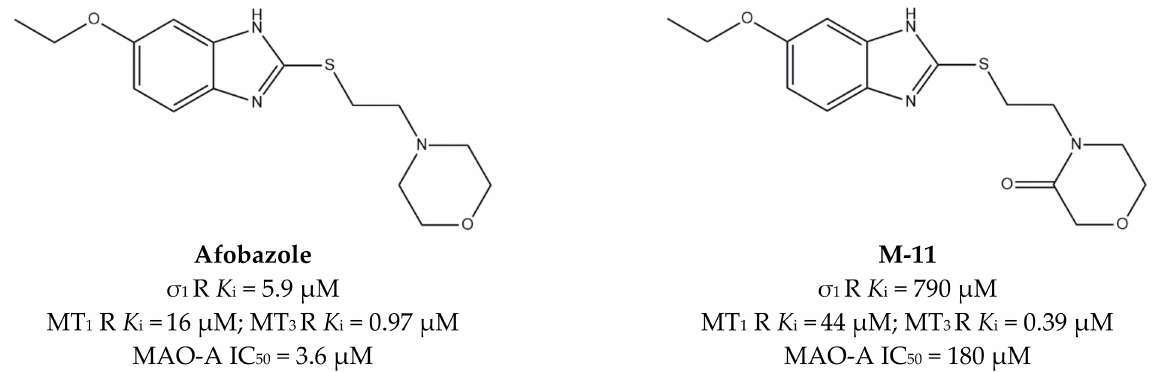
Figure 11. Afobazole and M-11 structures and their K i and IC 50 values for σ 1 receptor ( σ 1 R), melatonin MT 1 and MT 3 receptors (MT 1 R and MT 3 R) and monoamine oxidase A (MAO-A),